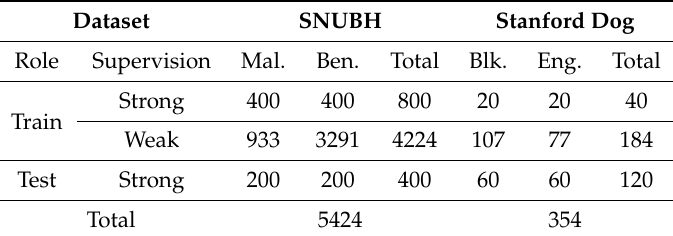
Table 1. Cardinality of SNUBH and Stanford Dog Dataset.